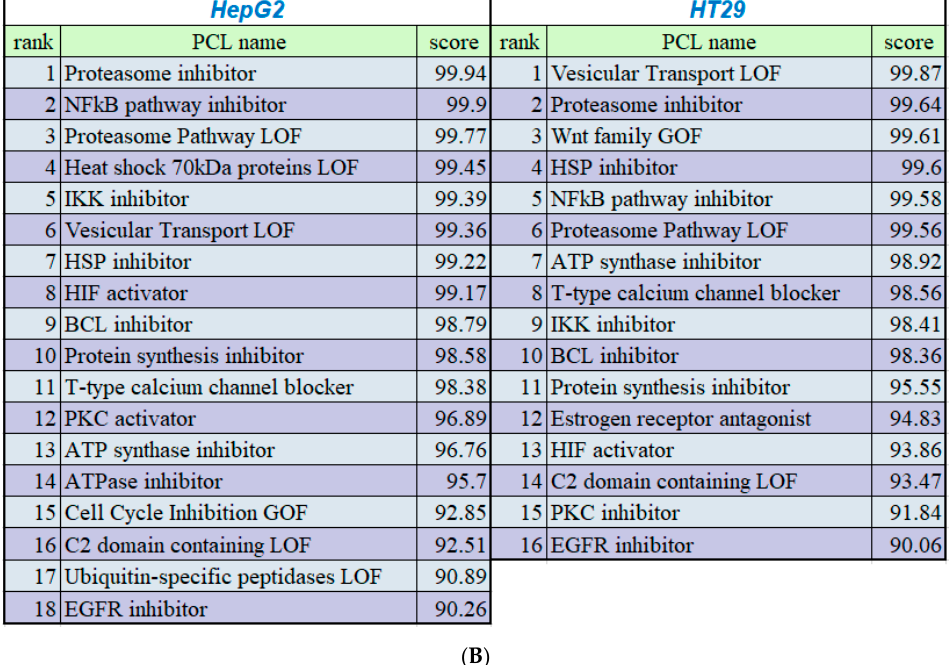
Figure 1. Gene analysis of curcumin. ( A ) The microarray data represent the L1000 gene-expression profiles of HT29 and HepG2 cells treated with curcumin (top, left). Using these gene expression signatures to query the CLUE (C-Map and LINCS (library of integrated network-based cellular signatures) unified environment) database, we obtained compounds or short hairpin RNAs (shRNAs) with similar gene expression signatures stored in CLUE according to the connectivity score (shown in blue). The top 30 compounds are presented at the bottom of the figure. The complete list is provided